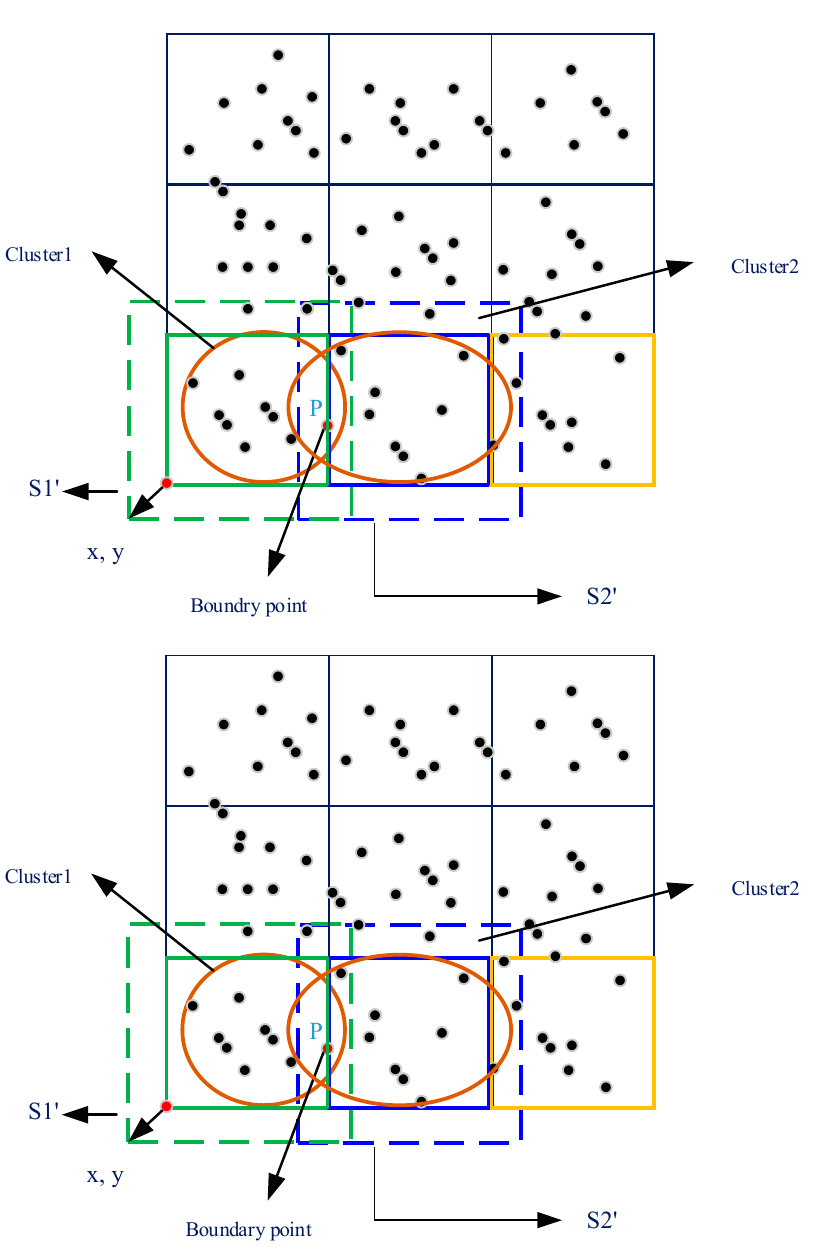
Figure 11. Data merging stage.